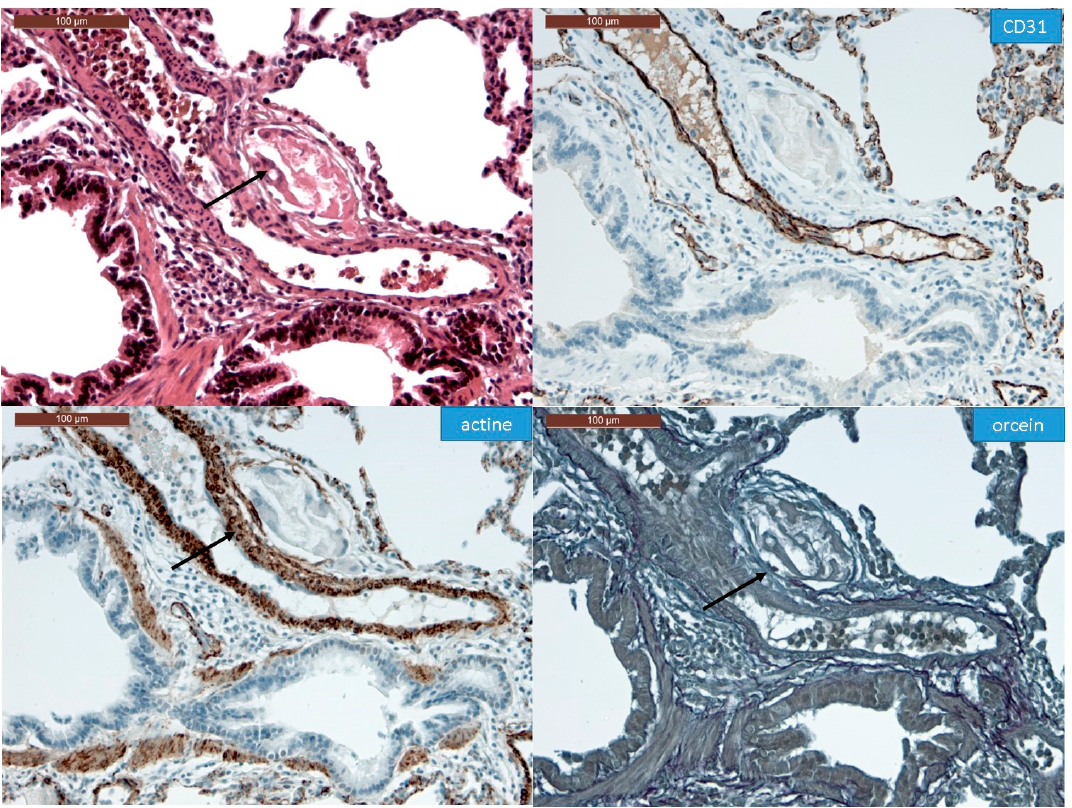
Figure 7. Immunohistochemistry of Stage III angiophagy in the large animal model of CTEPH (longitudinal cut). The hematein–eosin–saffron coloration (left upper panel) shows an embolic specimen (arrow) outside the media in the adventitia of the pulmonary artery. The embolic specimen is separated from the pulmonary artery lumen by endothelial cells (CD31 staining, right upper panel, arrow) and organized smooth muscle cells (actin staining, left lower panel, arrow). The adventitia seems disrupted at the contact of the embolic specimen (orcein staining, right lower panel, arrow).